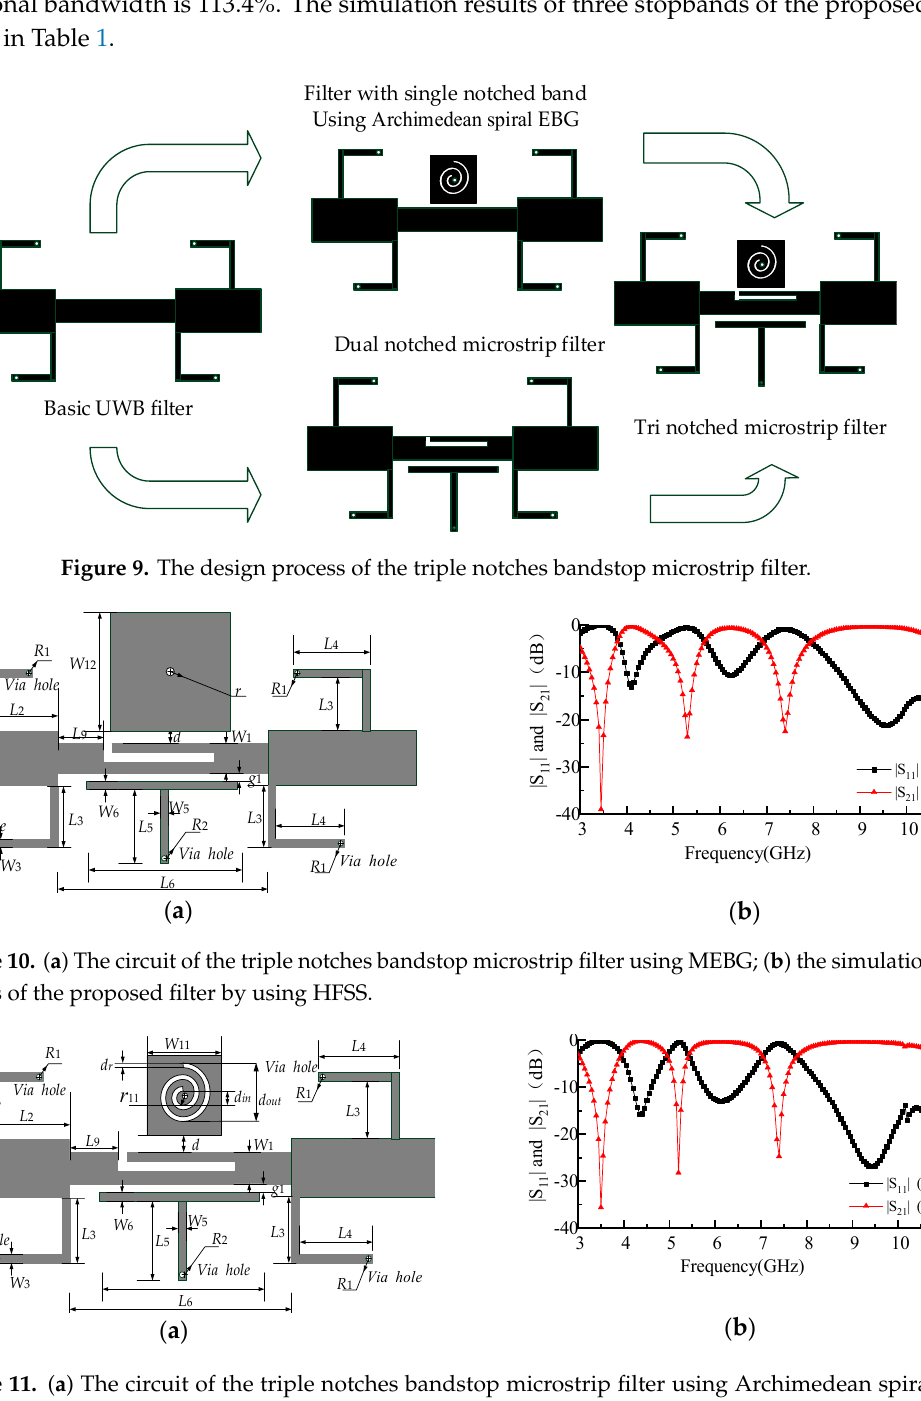
Figure 11. ( a ) The circuit of the triple notches bandstop microstrip filter using Archimedean spiral electromagnetic bandgap structure (ASEBG); ( b ) the simulation results of the proposed filter by using HFSS.